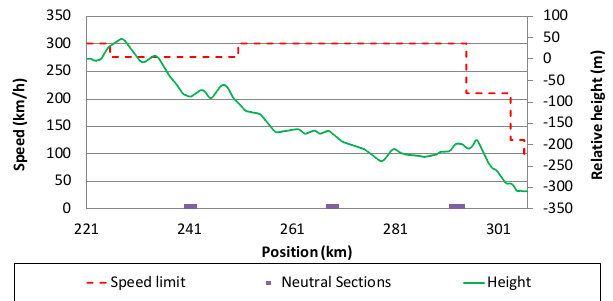
Figure 2. Track profile, maximum speed limits and neutral zones distribution.